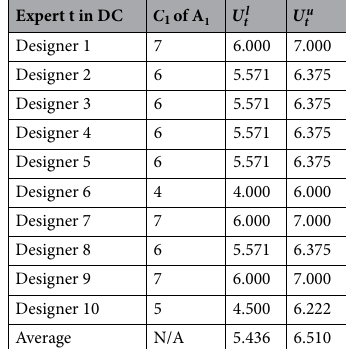
Table 5. Preference values and corresponding limits of interval U